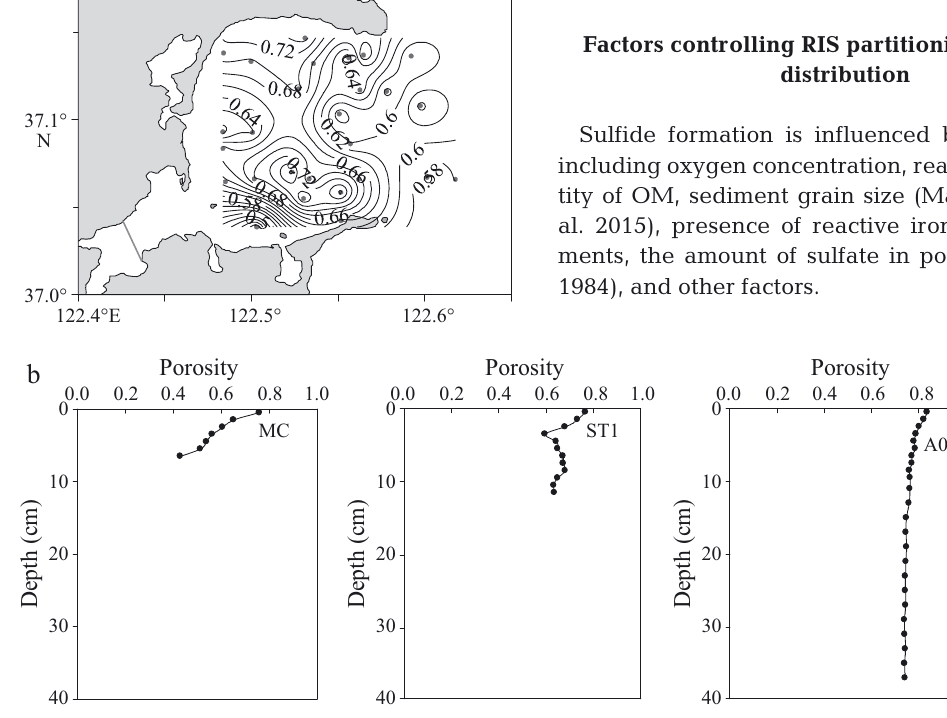
Fig. 6. Porosity of (a) surface and (b) core sediments of Sanggou Bay and the Yellow Sea (see Fig. 1 for station locations)